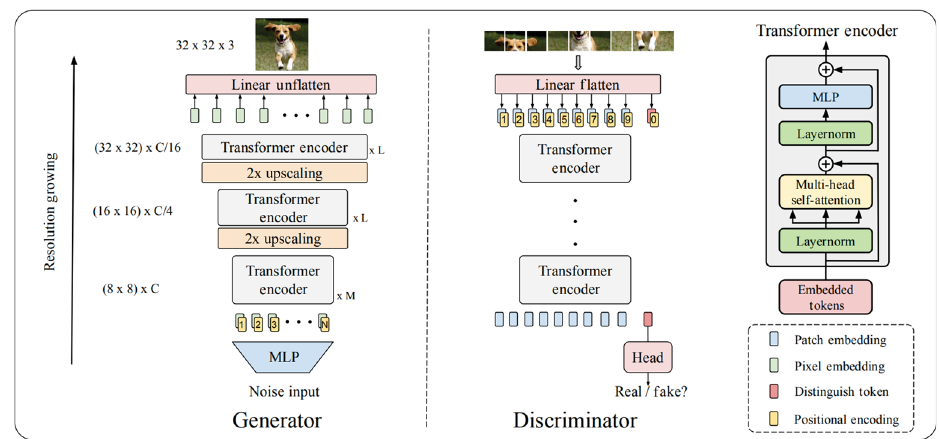
Fig. 17 Model overview of TransGAN. Reproduced with permission from Ref. [34], c (cid:2) The Author(s) 2021.